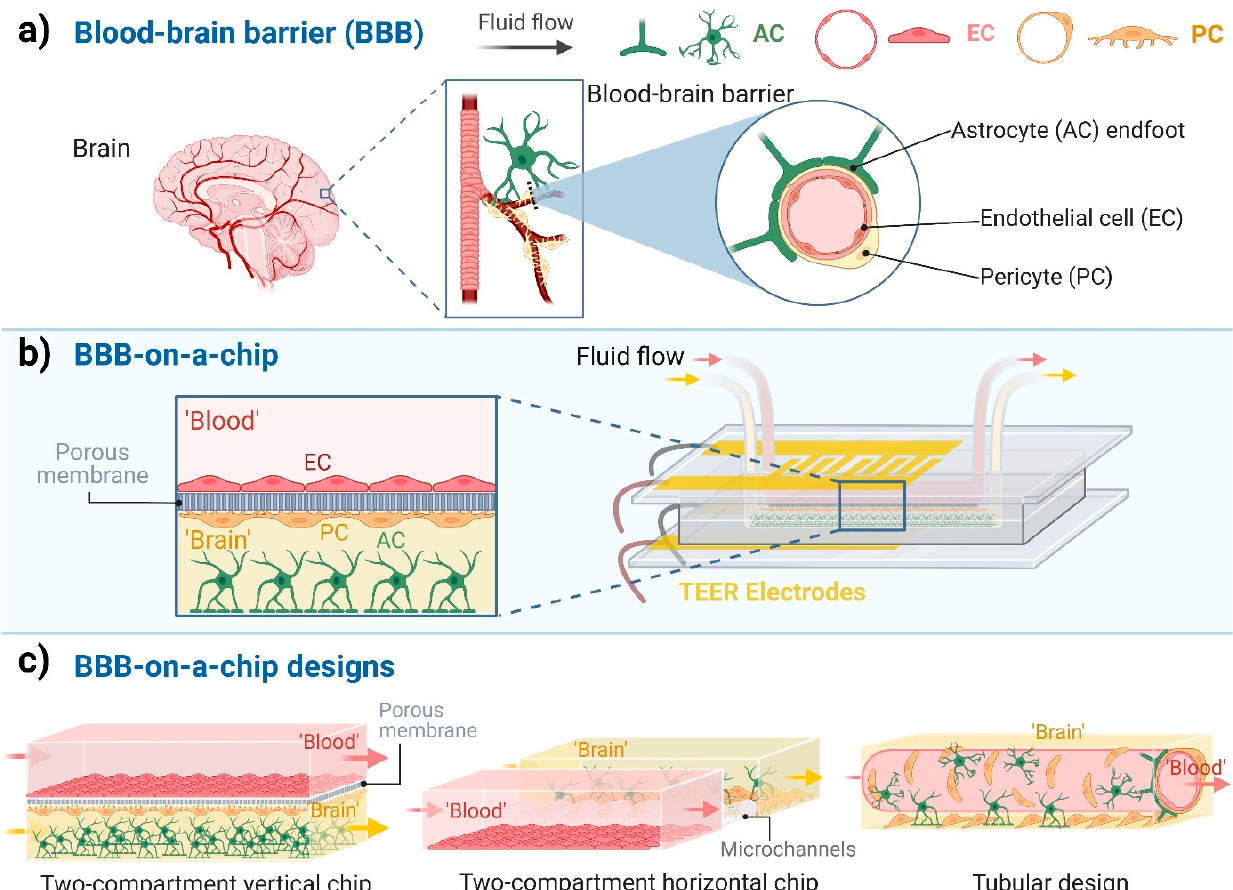
Figure 1. Blood-brain barrier-on-a-chip models. ( a ) The cellular composition of the blood-brain barrier (BBB). Endothelial cells (EC), which are the functional basis of the BBB, are surrounded by pericytes (PC) and the astrocytes’ endfeet (AC). ( b ) Schematic representation of a BBB-on-a-chip design with two compartments separated by a porous membrane and the co-culture of three cell types. ‘Blood’ represents the compartment with fluid flow in contact with the luminal plasma membrane of ECs. ‘Brain’ indicates the abluminal compartment in which the PCs and ACs are cultured. ( c ) Different designs of BBB-on-a-chip models. Created with BioRender.com.